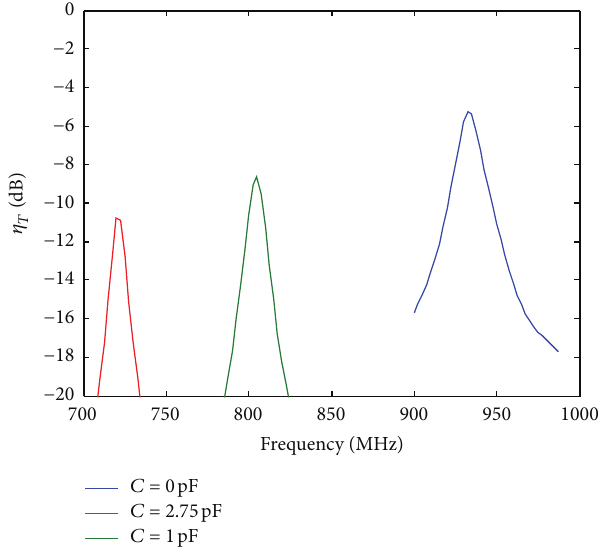
Figure 14: Measured total efficiency of the demonstrator in Figure